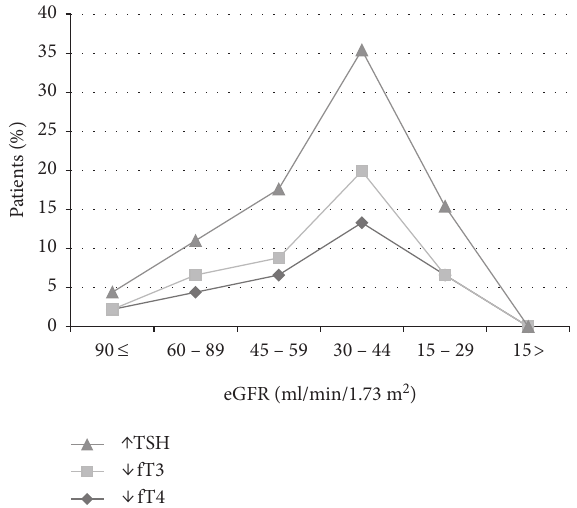
Figure 6: Prevalence of low fT3, fT4, and TSH in different stages of CKD. The first top line shows elevates TSH (thyroid-stimulating hormone), middle line is indicative of declined fT3 (free triiodo- thyronine), and bottom line shows fT4 (free thyroxin). CKD, chronic kidney